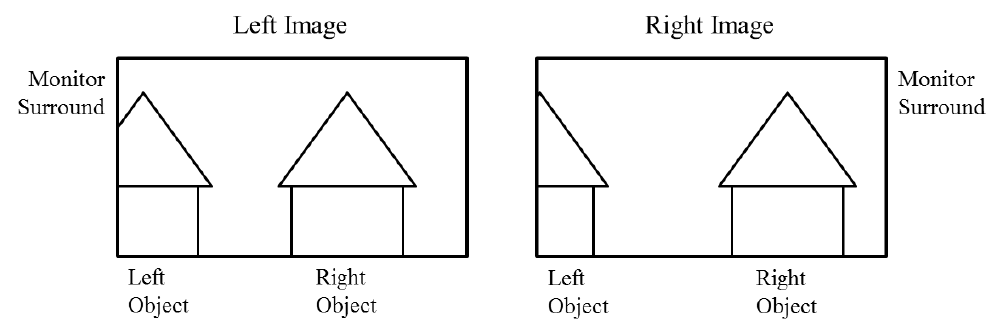
Figure 4. Example of